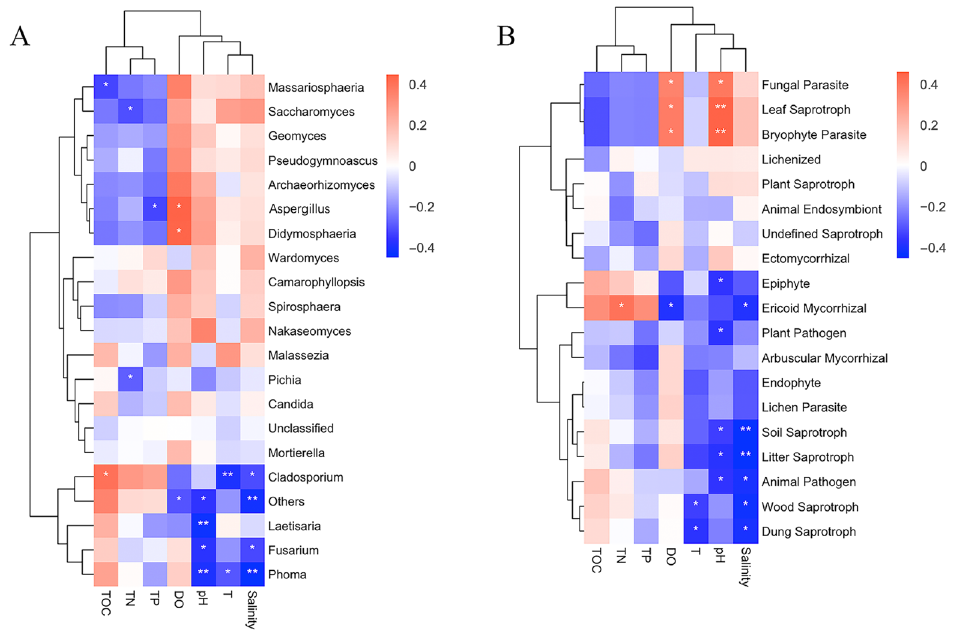
Figure 5. Heatmap of the correlation between ( A ) fungal community composition (top 20) and environmental factors of taxonomic genera, and ( B ) fungal trophic modes composition (top 19) and environmental factors.